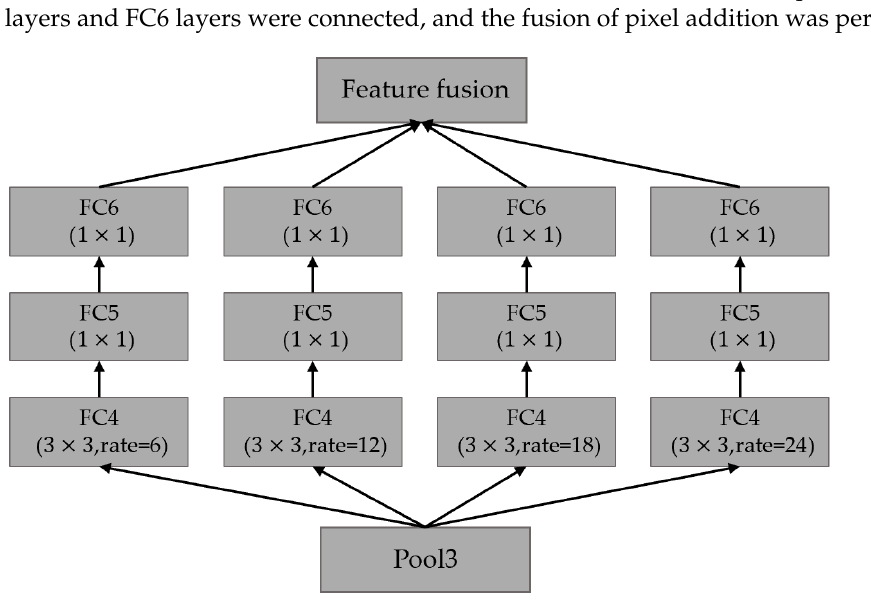
Figure 5. Atrous spatial pyramid pooling module.